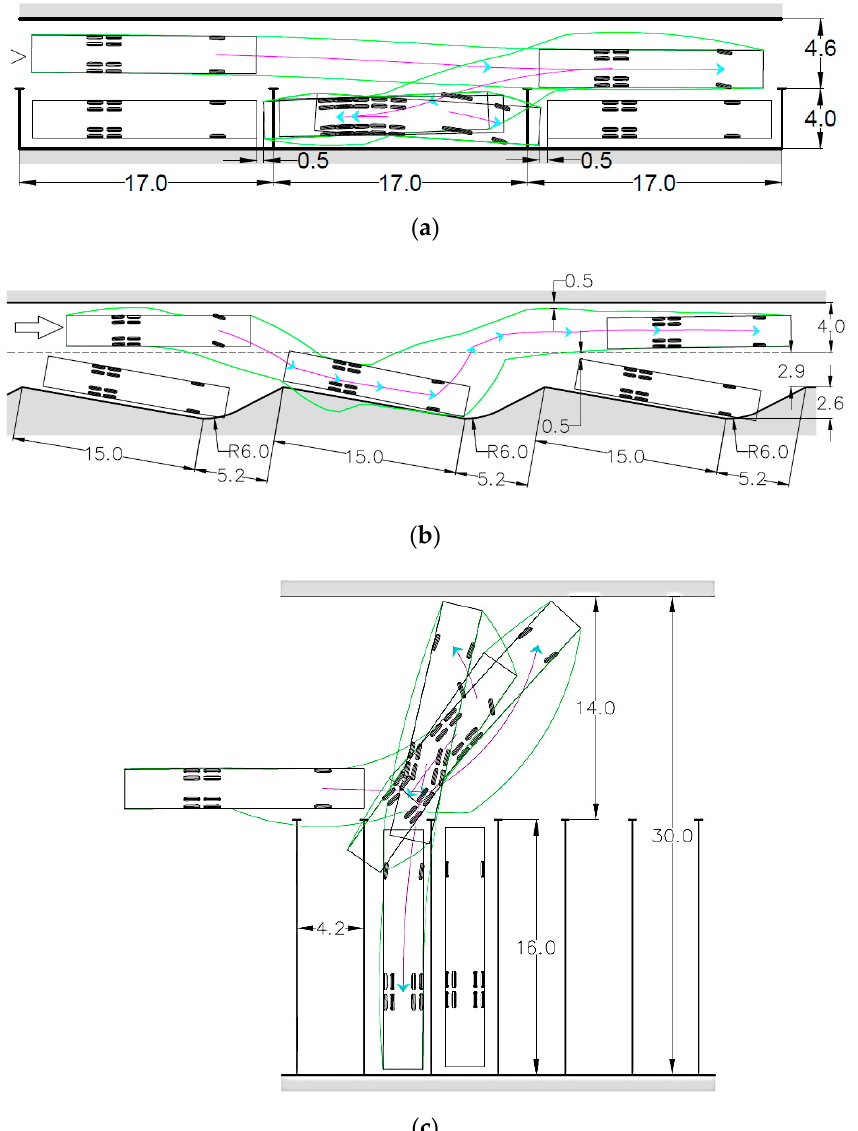
Figure 14. Scheme and dimensions of parking spaces for a bus: ( a ) when parallel; ( b ) saw tooth; ( c ) a perpendicular placement in relation to the driveway or manoeuvring zone (similar scheme is proposed for other types of buses).